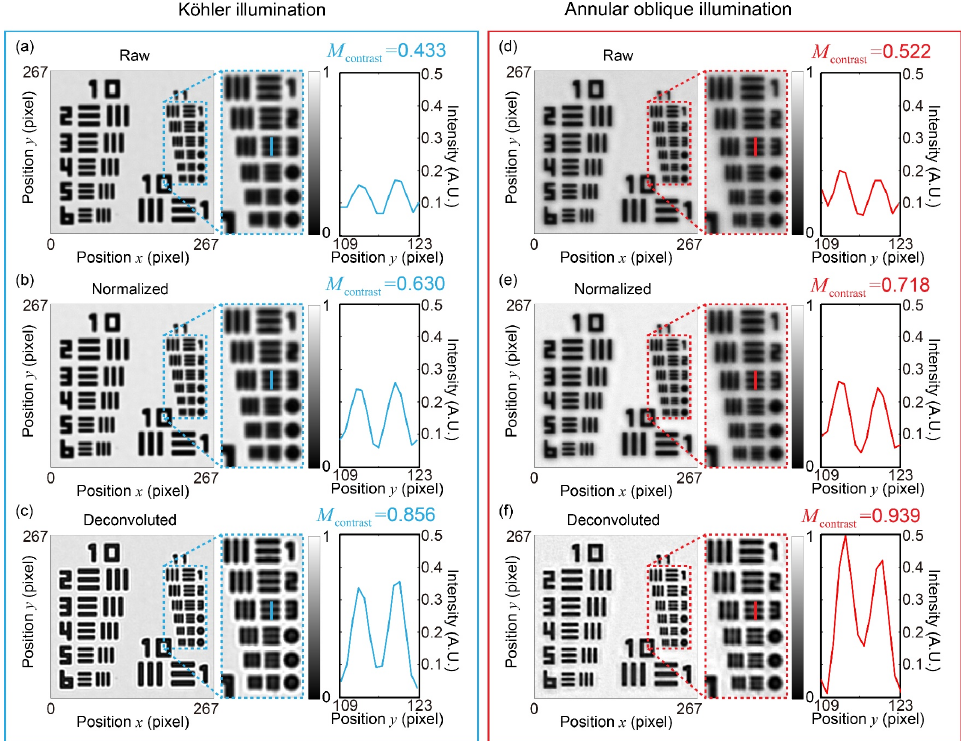
Figure 10. The resolution target images: ( a ) is a raw Köhler-illuminated image, ( b ) is the normalized image of ( a ), ( c ) is the deconvoluted image of ( b ); ( d ) is a raw annular oblique-illuminated image, ( e ) is the normalized image of ( d ), ( f ) is the deconvoluted image of ( e